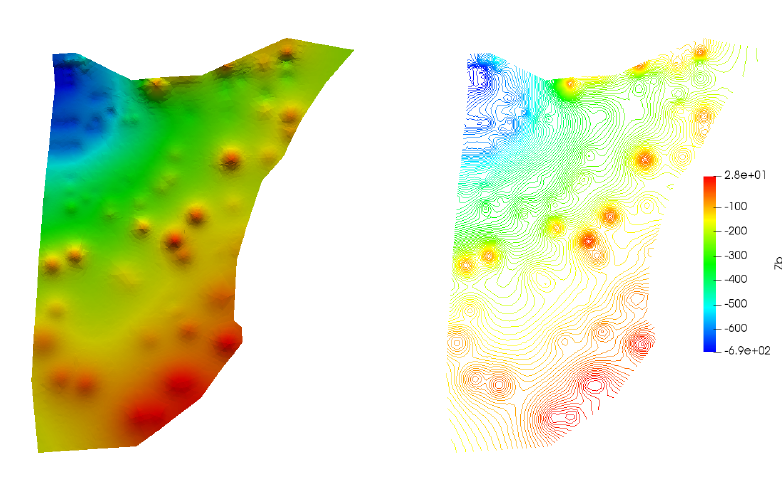
Figure 10. Bottom elevation contours of the aquifer.